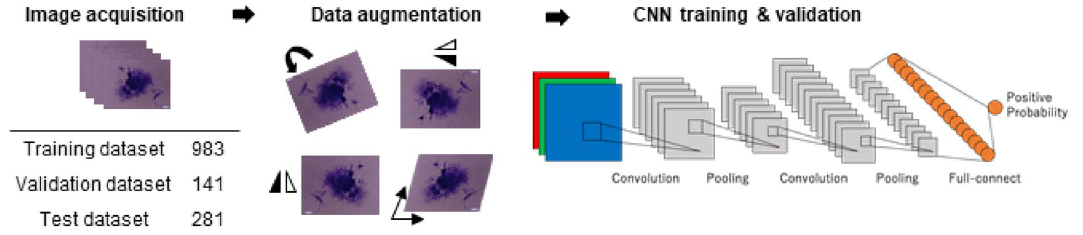
Figure 2. Deep learning with datasets on Bhas CTA. A total of 1405 datasets were acquired by Bhas 42 CTA and classified into 3 data: 983 training data (70%), 141 validation data (10%), and 281 test data (20%). During the training, data augmentation such as rotation and translation was applied to the input images, and data augmentation was performed. CNN training was carried out for 50 epochs, and the parameters of CNN when the accuracy for validation data became maximum were used. Trained CNNs were evaluated with test